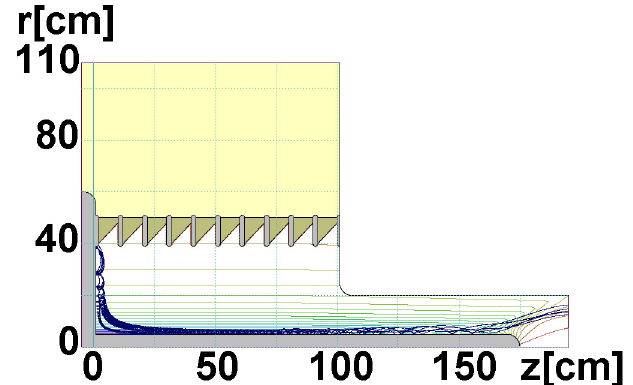
6. (Color) TRAK [14,15] ray-tracing calculation of the space FIG. 7. (Color) The trajectories of the electrons shown in Fig. 5 charge limited emission from the central stalk of the device of are also drawn. in the presence of the beam generated magnetic and electric Fig. 5. Contours of the beam generated B (cid:3) 2.4 MV is applied and the total current obtained is 44 kA. fields as calculated in Fig.